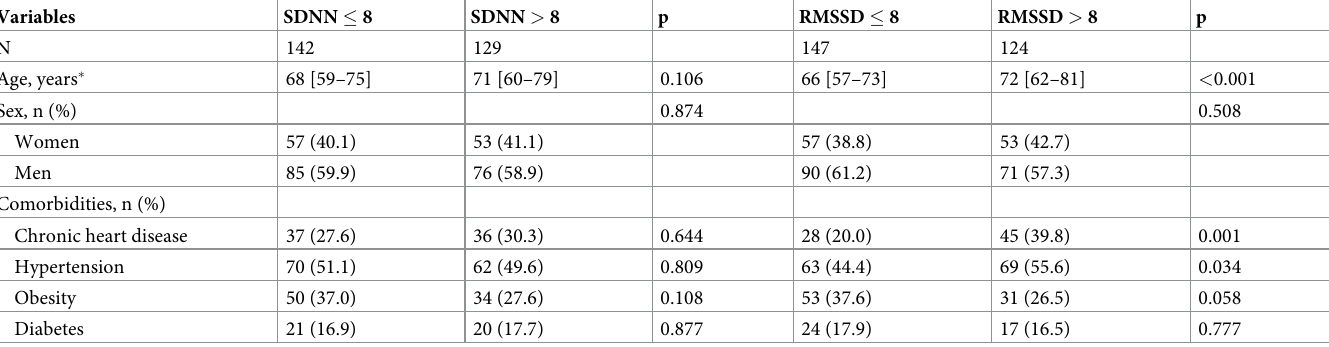
Table 1. Descriptive data of included patients according to heart-rate-variability (HRV).